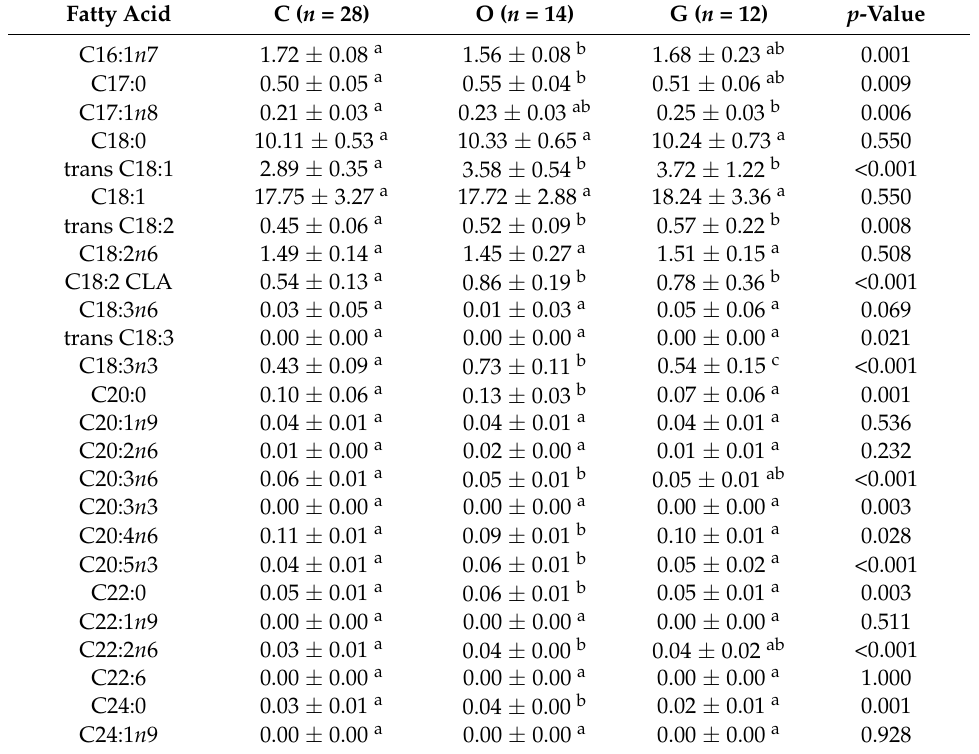
Figure 3. Comparing the contents of saturated fatty acids (SFA), monounsaturated fatty acids (MUFA), polyunsaturated fatty acids (PUFA), trans fatty acids (TFA), and other fatty acids (OFA) in conventional, organic, and grass butters. Error bars represent standard deviations. SFA and PUFA contents as well as omega ‐ 3 and omega ‐ 6 FA contents tended to be higher in butters purchased in summer than those purchased in winter for all types of butter; MUFA and omega ‐ 9 FAs showed the opposite trend. Delgadillo ‐ Puga also described a significant difference between samples collected in January and June in SFA and MUFA in conventional raw milk and for PUFA in organic raw milk [25]. An increase in PUFA and omega ‐ 3 in grass ‐ fed dairy was expected, since these groups of FAs are more abundant in grass than in conventional feed [26]. 4. Conclusions